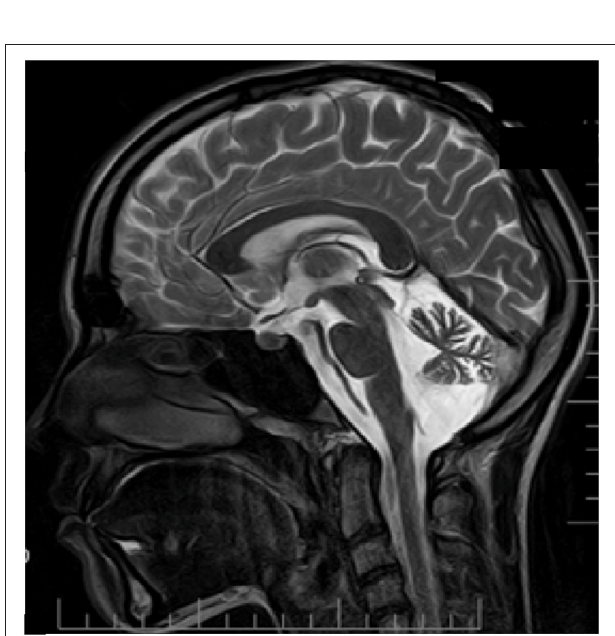
FIGURE 3 | MRI examination (T2 weighted sagittal image) of patient D. Notice clear cerebellar atrophy. Patient information and technical text were closed.